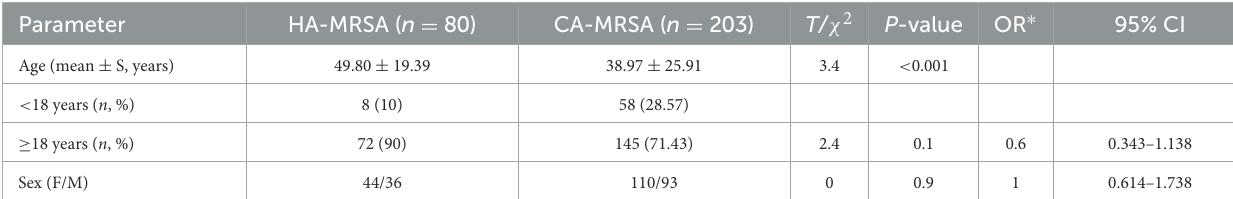
TABLE 2 Comparison of the demographics of skin and soft tissue healthcare-associated methicillin-resistant S. aureus (HA-MRSA) and community-associated methicillin-resistant S. aureus (CA-MRSA) infections.